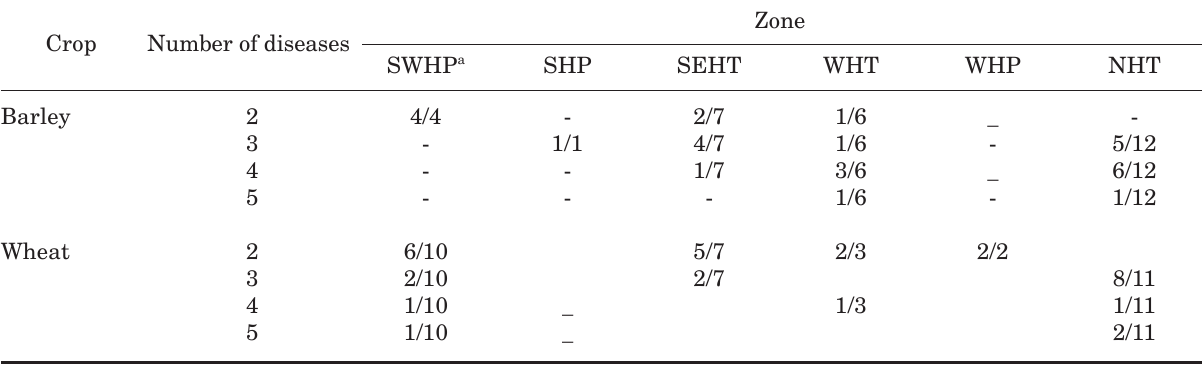
Table 7. Number of diseases per field found on barley and wheat in Eritrea in 2001.